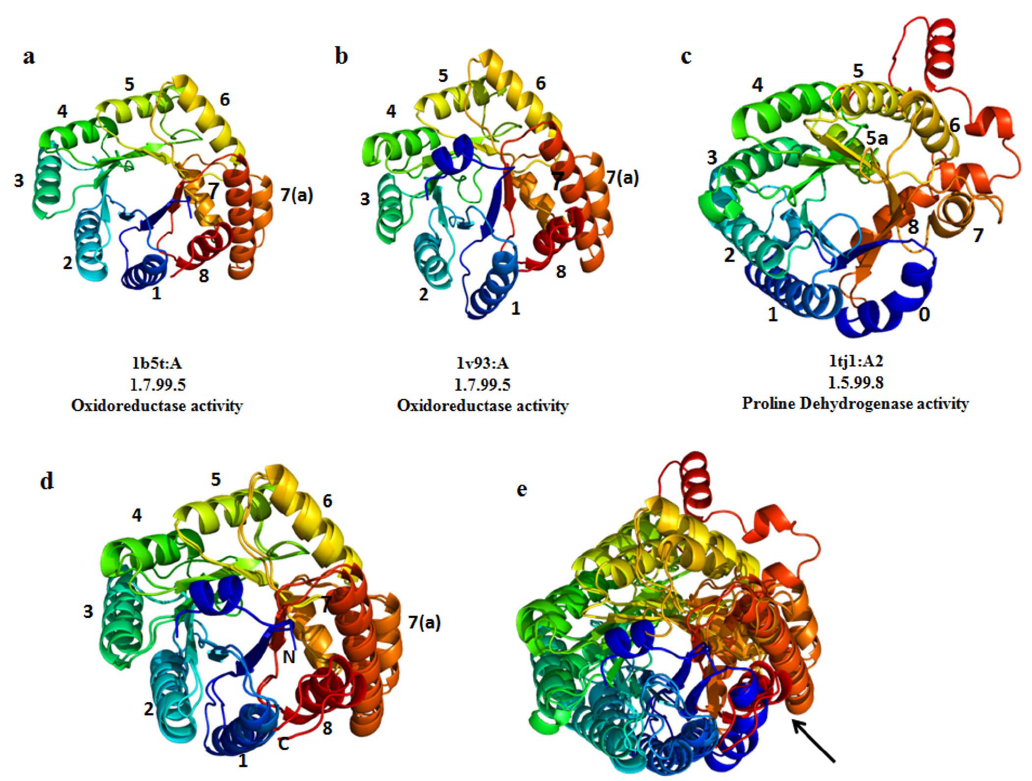
Figure 5. The structural difference between the MTHFR and PutA PRODH families. 1tj1 is the structurally deviant member of the FAD- linked oxidoreductase superfamily. The topology of 1tj1 structure is slightly different from the classic b 8 a 8 barrel topology and also functionally diverse. The Helix number is also shown in the figure. The pdb ID and the chain ID along with their EC number and enzymatic activity are mentioned. The figures are made in pymol with spectrum coloring which shows N-terminus(blue) to C-terminus(red).(d) The superposed pose of 1b5t and 1v93 (f) Superimposed view of all the three domains (1b5t,1v93 and 1tj1).The N-terminus helix in 1tj1 is aligned with C-terminal helix of the other two domains (shown with an arrow). All other helices are not aligned